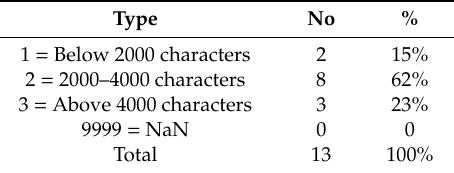
Table A4. The length a of the